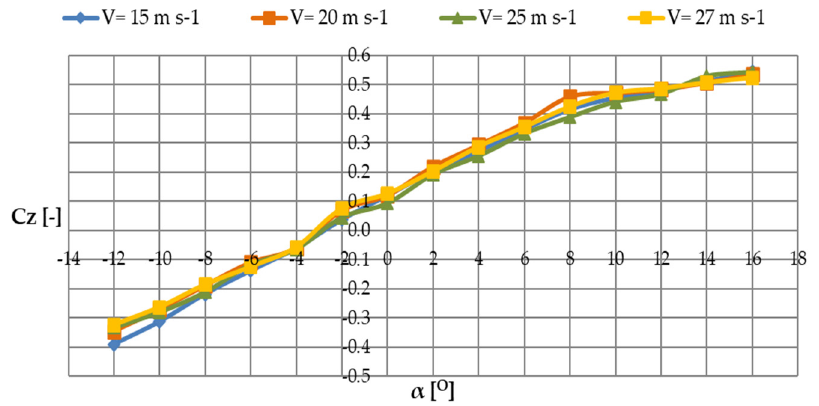
Figure 12. Summary plot of lift force coefficient, Cz, for positive and negative angles of attack, α , for all airflow speeds tested.